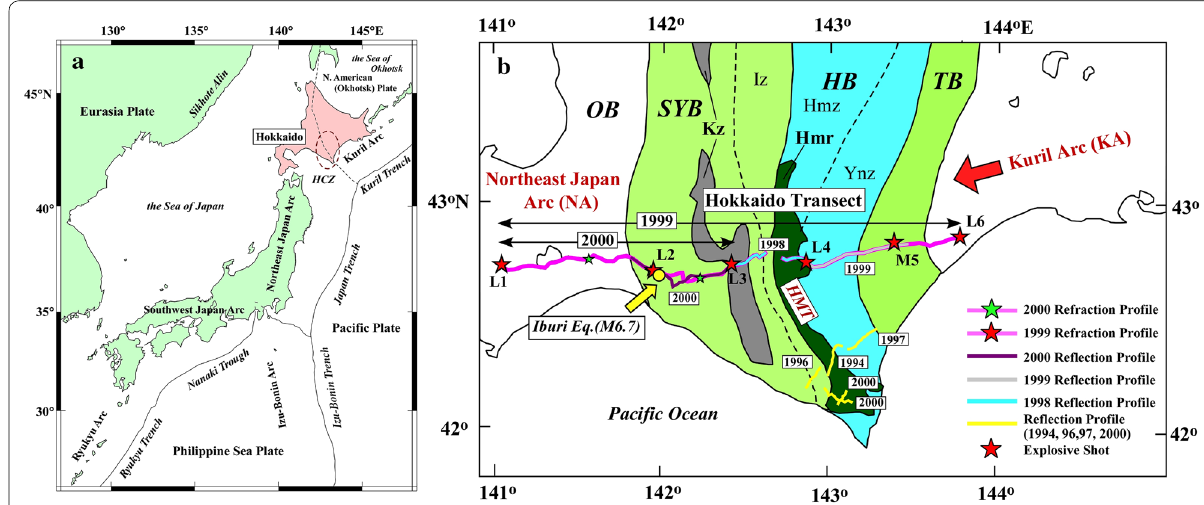
Fig. 1 Tectonic maps in and around Hokkaido, Japan. a Tectonic map in and around Japan. Our study area of Hokkaido, the northernmost island in Japan, is colored in pink. HCZ: the Hidaka Collision Zone. b Geological units forming Central Hokkaido (Kimura 1994; Ueda 2016) and seismic reflection and refraction/wide-angle reflection lines of the 1998–2000 Hokkaido Transect (Iwasaki et al. 2001, 2004; RGES 2002a, b). Other reflection lines in the southern part of Central Hokkaido (e.g., Arita et al. 1998; Tsumura et al. 1999; Ito 2000, 2002) are also shown. A yellow circle indicates the epicenter of the Hokkaido Eastern Iburi earthquake (M 6.7) on Sep. 6, 2018 by Japan JMA (2018a). OB: Oshima Belt; SYB: Sorachi-Yezo Belt; HB: = Hidaka Belt; TB: Tokoro Belt; Iz: Idon’nappu zone: Hmz: Main zone of the HB; Ynz: Yubetsu-Nakanogawa zone of the HB; Kz: Kamuikotan zone; Hmr: Hidaka metamorphic rocks; HMT: Hidaka Main